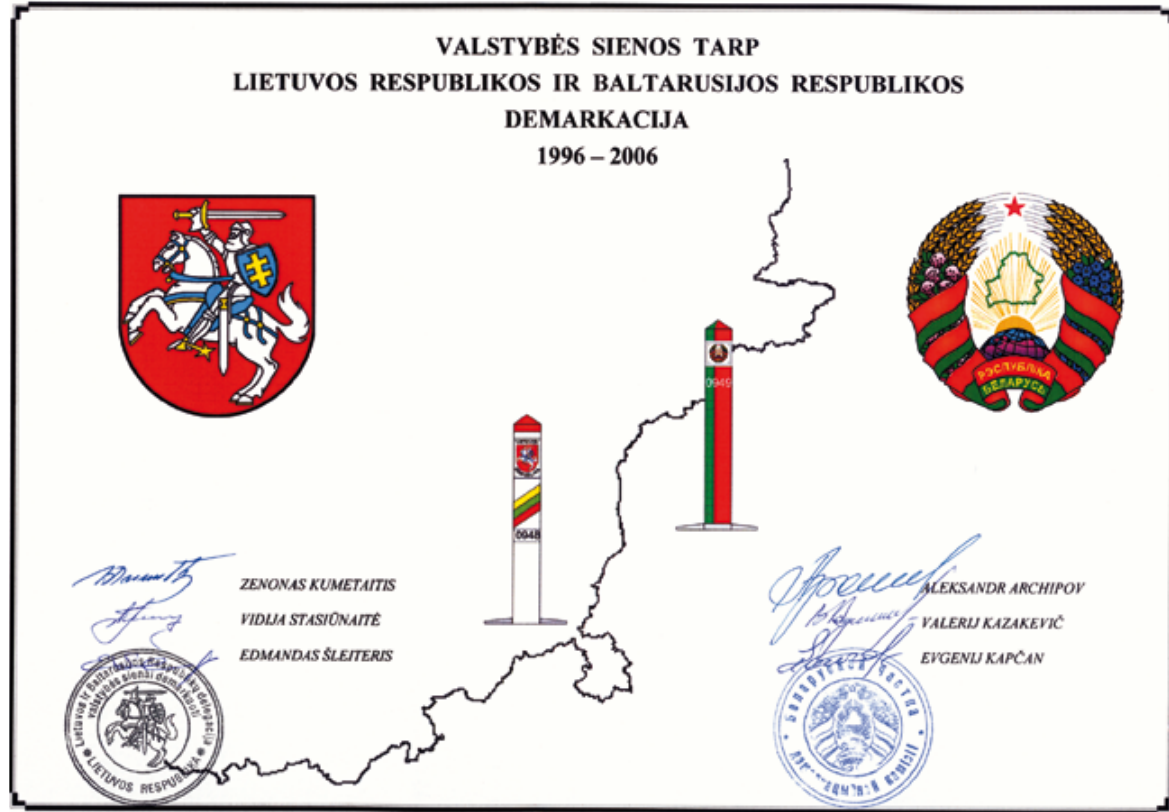
Fig. 6. State boundary demarcation